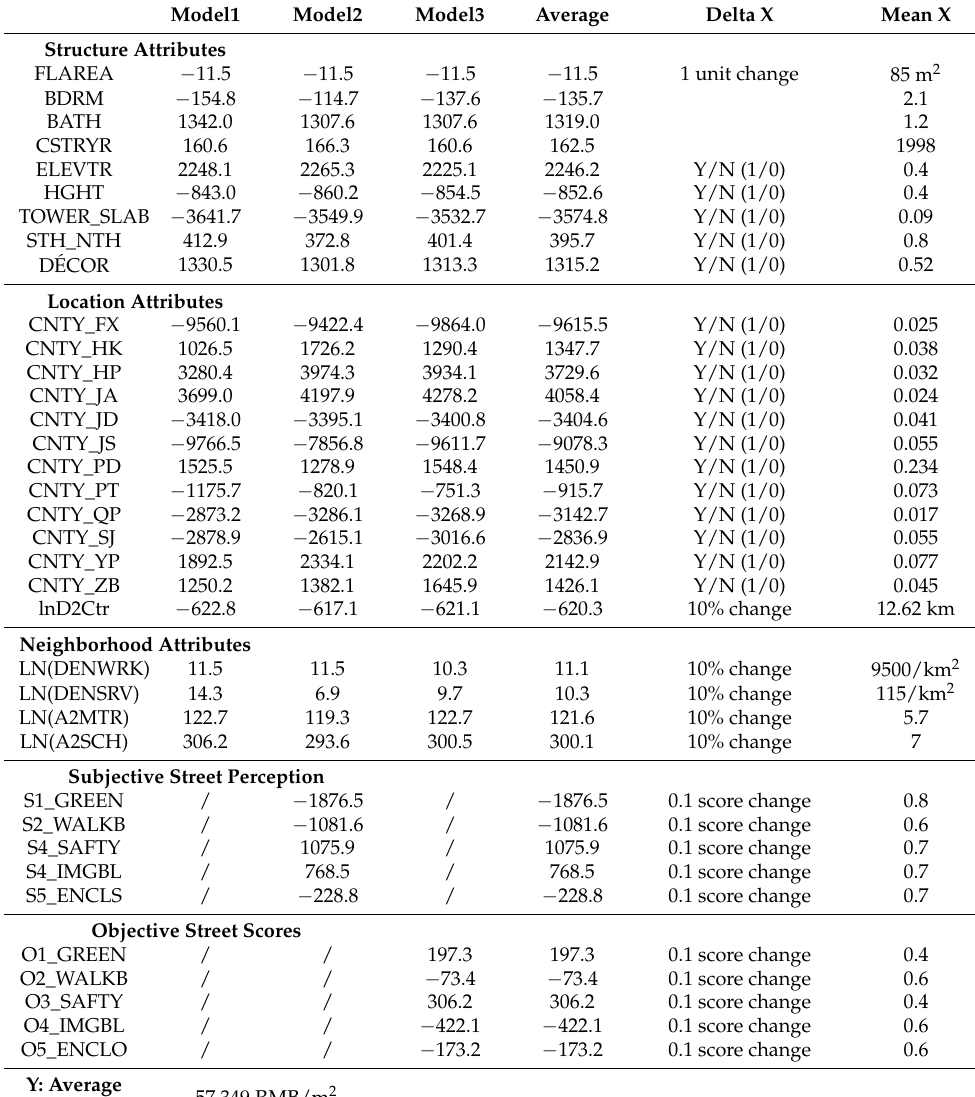
Table A1. Interpretation of regression coefficients (converted to RMB/m 2